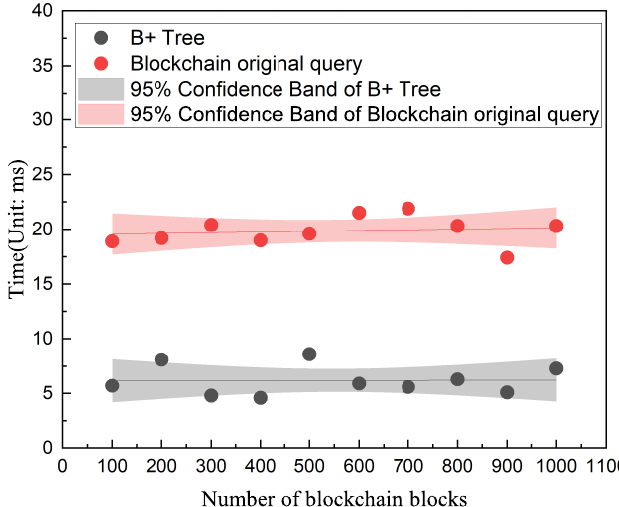
Figure 13. Query time